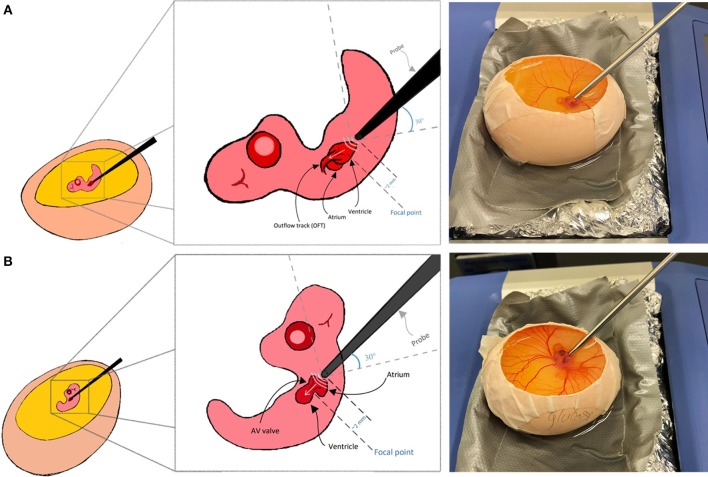
Chick embryo orientation for Doppler echocardiography analysis. (A) For outflow track blood flow measurement, the embryo is kept laying on its left side and the transducer probe is oriented as shown in the figure. (B) For blood flow measurement at the atrioventricular valve, embryo should be gently flipped using a blunt forceps and the transducer probe should be oriented as shown in the figure.